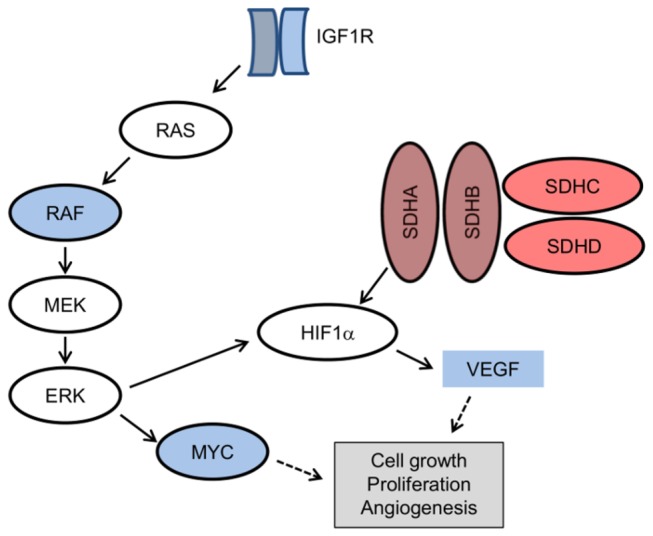
Altered mRNA levels in wild-type/PDGFRA-mutant gastrointestinal stromal tumors (red, decreased; blue, increased).